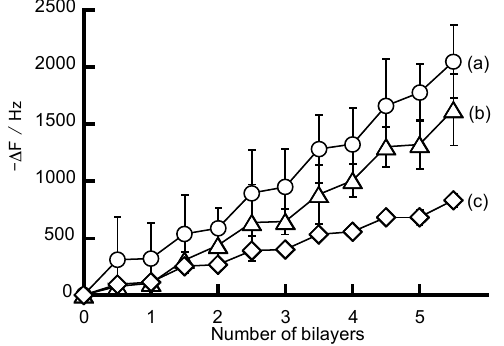
Figure 2. QCM frequency change for the deposition of ( a ) Nafion poly(allylamine hydrochloride) (NAF-PAH); ( b ) Nafion poly(ethyleneimine) (NAF-PEI); and ( c ) Nafion poly(diallyldimethylammonium chloride (NAF-PDDA) LbL films.